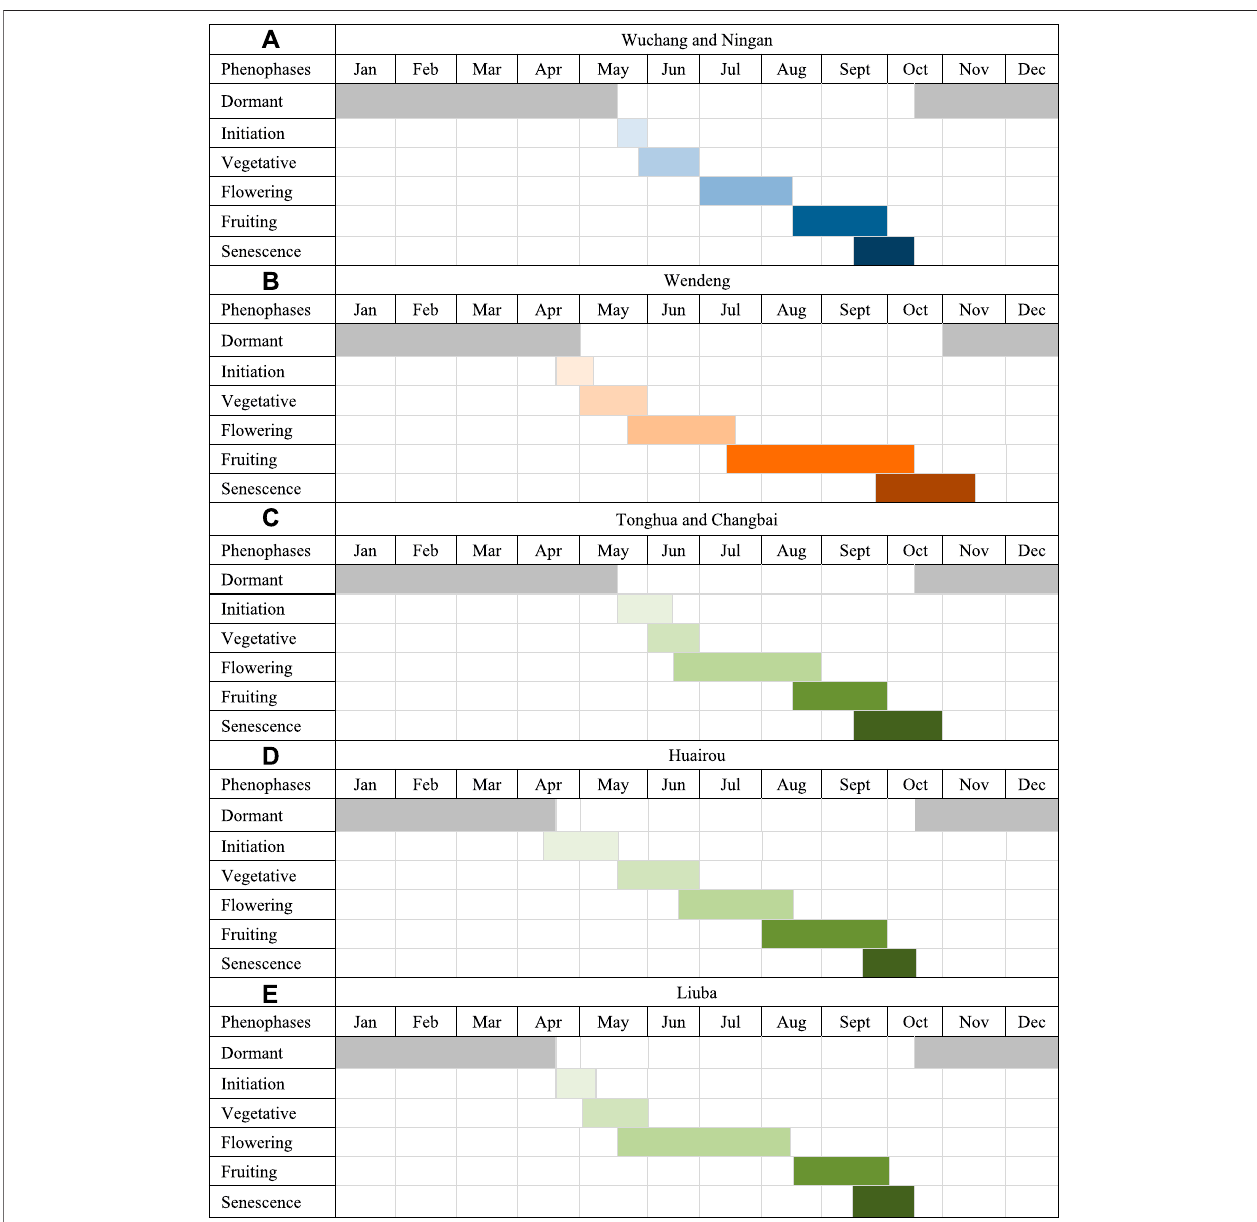
FIGURE 4 | Comparison of phenological stages of American ginseng in seven cultivated locations in China.